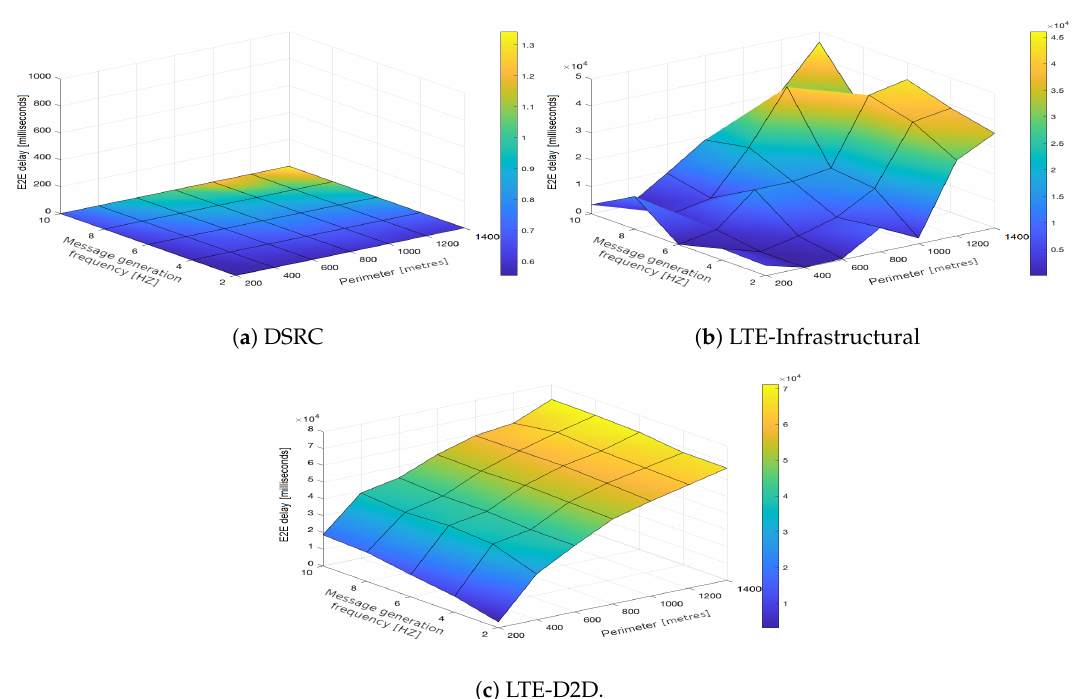
Figure 13. End-to-end delay obtained for the traffic intensity of 1500 vehicles per